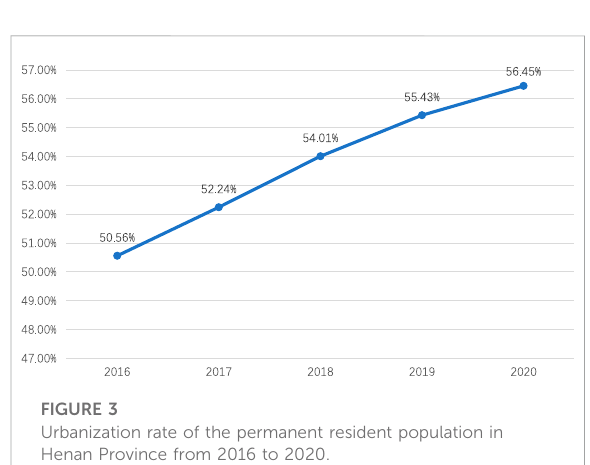
FIGURE 4 Comparison of urban and rural residents ’ income in Henan